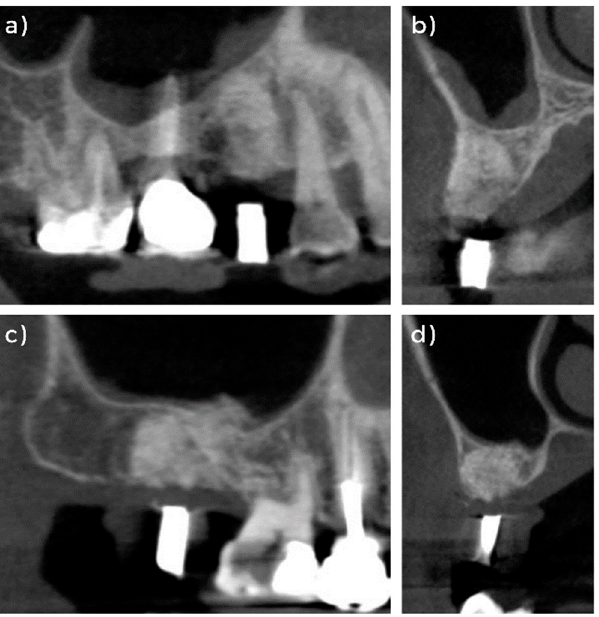
Figure 3. CBCT images of Case I ( a ) lateral view, ( b ) cross-sectional view taken one year after alveolar ridge preservation (ARP); Case II ( c ) lateral view, ( d ) cross-sectional view taken two years after ARP.